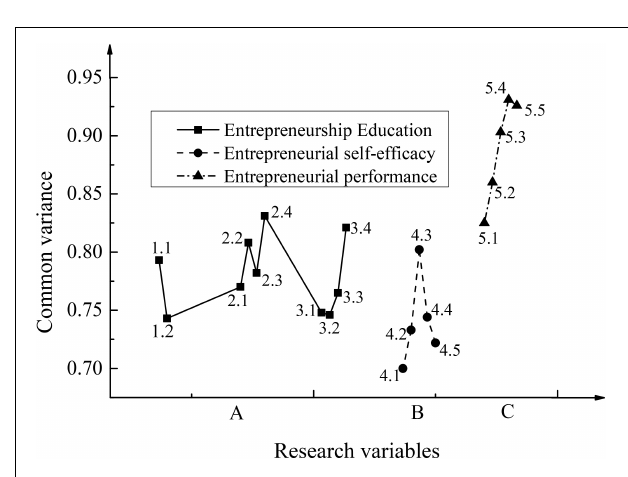
FIGURE 3 | KMO and Bartlett test results. In the figure, the abscissa (A) represents entrepreneurship education, (B) represents entrepreneurial self-efficacy, and (C) represents entrepreneurial performance.